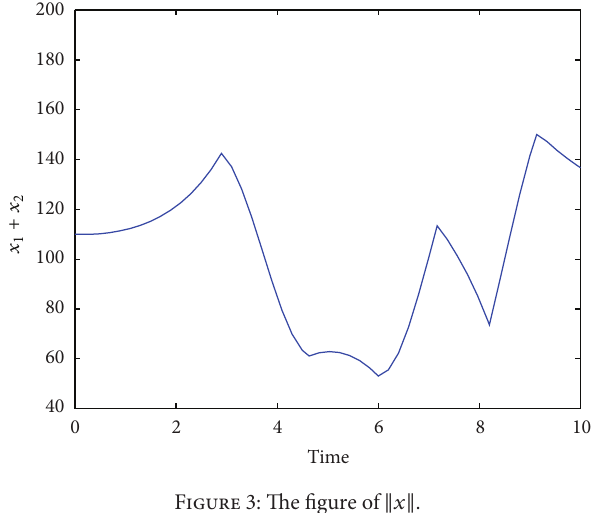
Figure 3: The figure of ‖𝑥‖